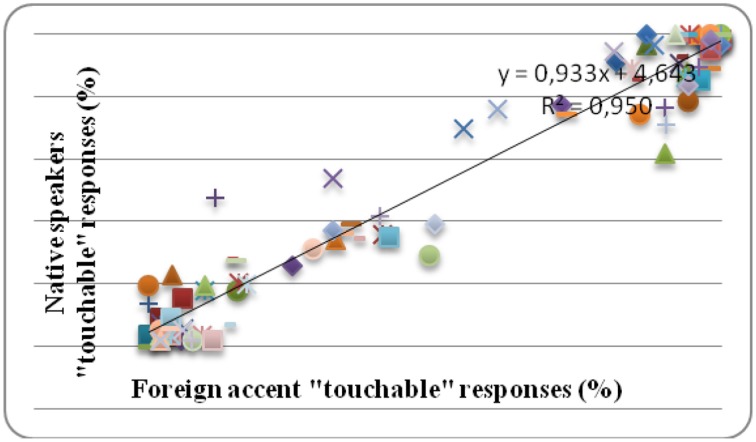
Percentage (%) of categorical responses for each word of each valence type in each accent group.